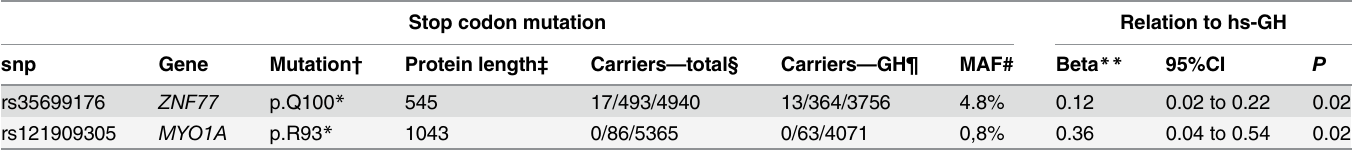
Table 3. Stop codon mutations fulfilling the criteria previously described. *